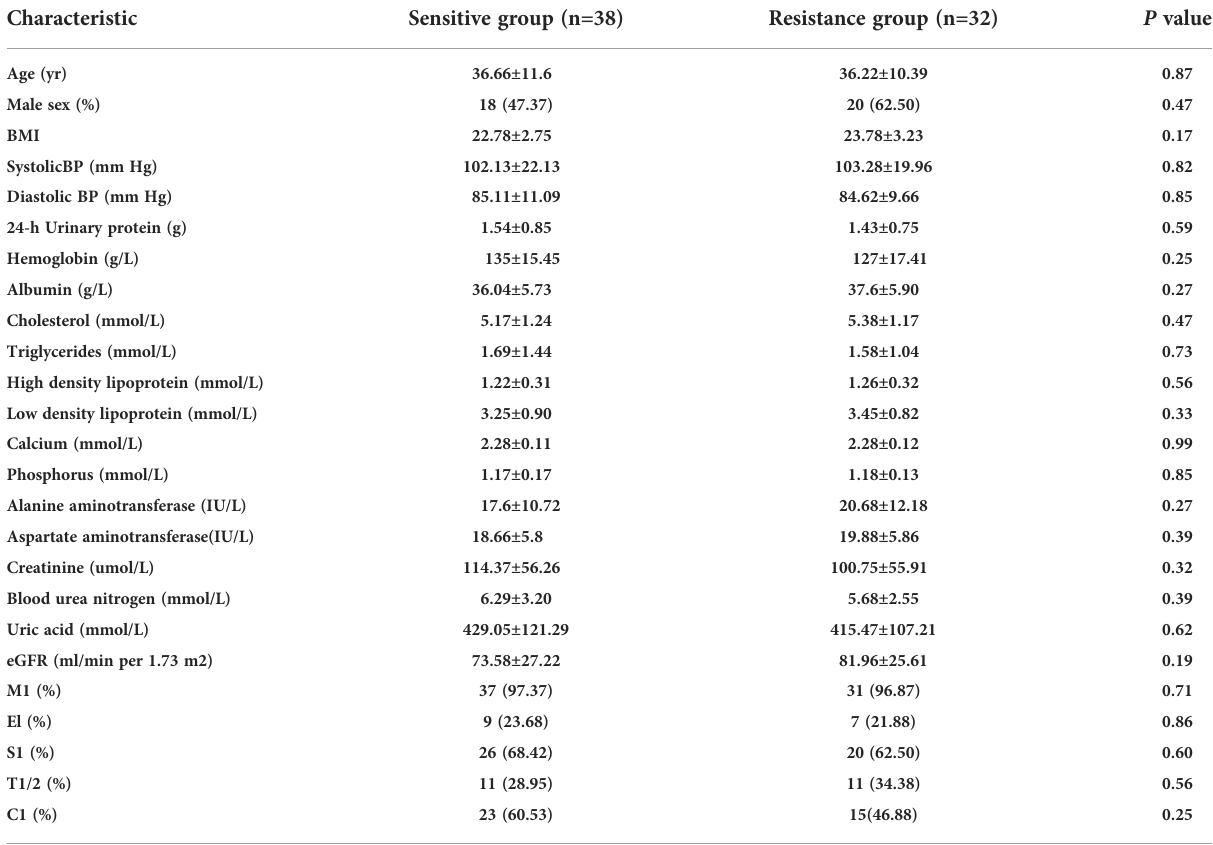
TABLE 1 Demographic, clinical and pathological characteristics of the sensitive and resistant